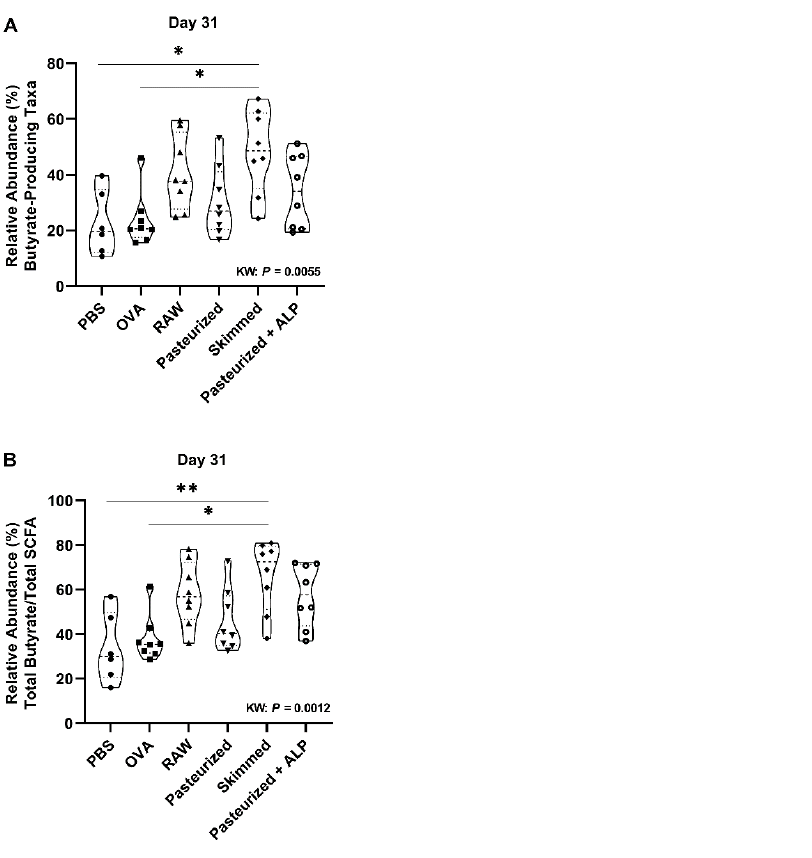
Figure 4. Skimmed raw milk is associated with increased butyrate-producing genera at day 31. The percent mean relative abundance of ( A ) putative butyrate-producing taxa and ( B ) total butyrate-to-total SCFA ratio examined is shown for the different control and experimental groups at day 31. Kruskal–Wallis results and Dunn’s post hoc test adjusted p -values shown: * p < 0.05, **